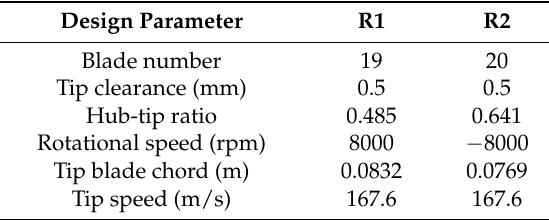
Figure 1. The two stage subsonic counter-rotating axial compressor: ( a ) overall view; ( b ) enlarged view of the blade rows; and ( c ) cross-sectional diagram. Table 1. Other main design parameters of the two rotors.